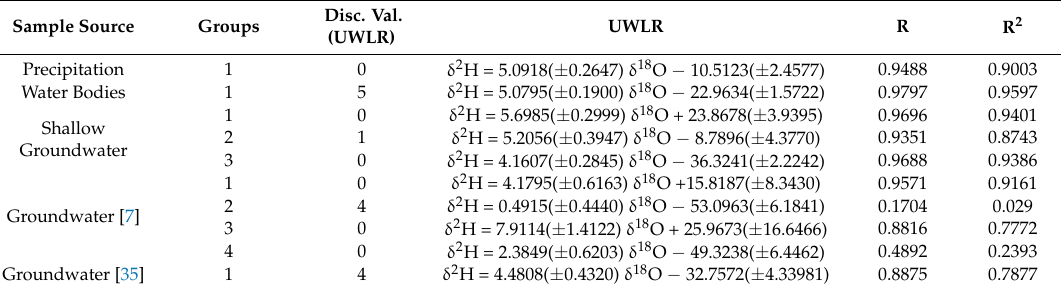
Table 3. Uncertainty weighted least-squares linear regression parameters from stable isotopic compositions of all water